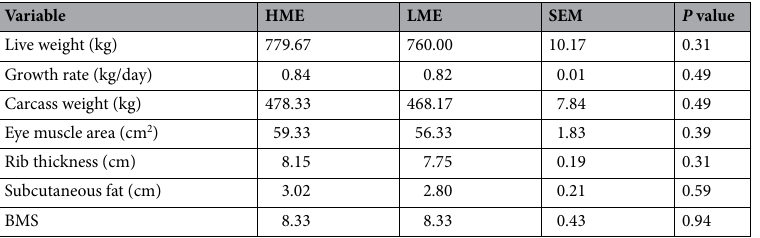
Table 2. Mean carcass traits in HME vs LME. HME: group of high methane emission cattle (n = 6), LME: group of low methane emission cattle (n = 6). Values indicate mean. SEM: standard error of the mean, BMS: beef marbling score (Japanese standards ranged from 1, which contains no visible marbling, up to 12, which is heavily